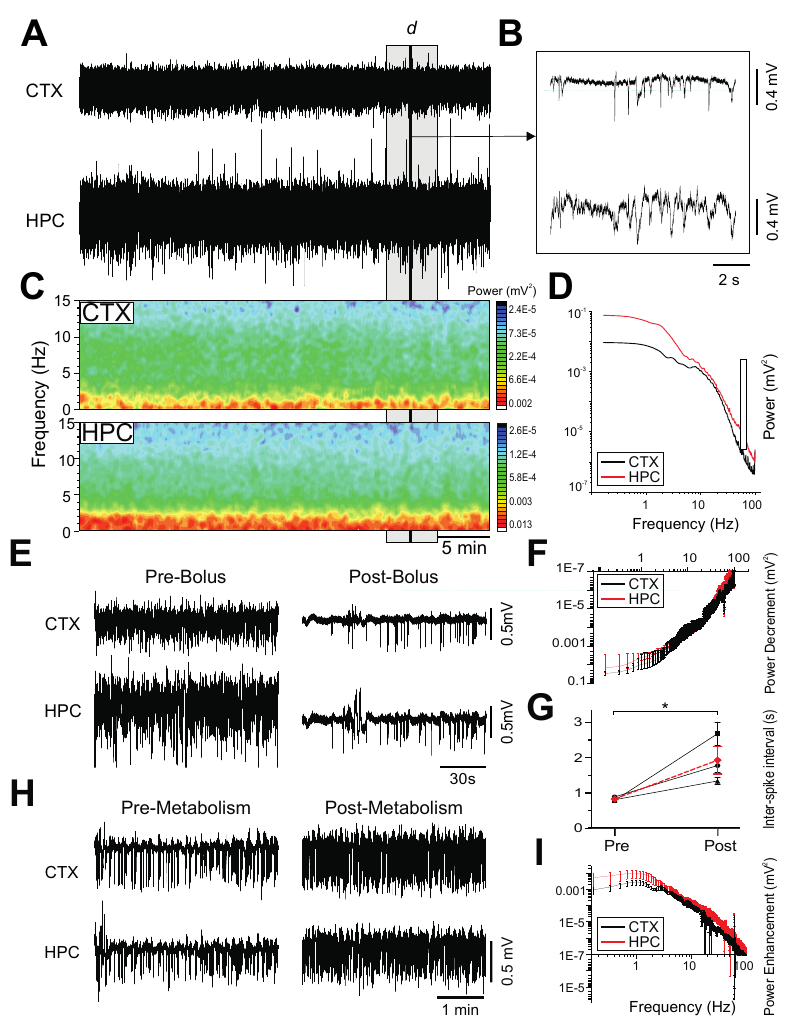
Figure 5. Burst-suppression activity under propofol anesthesia. ( A ): Continuous, 40 min duration cortical (CTX) and hippocampal (HPC) EEG traces. A 5 min (grey box) sample is further analyzed in D, and a 10 s (black line) sample is expanded in B. ( B ): Expanded 10 s trace of CTX and HPC from A (black line). ( C ): Spectrograms of CTX and HPC traces in A. ( D ): Power spectra of a 5 min selection from A (grey box), representative of the activity observed throughout the 40 min duration of the trace in A, due to continuous delivery of propofol. Noise at 60 Hz has been obfuscated by a white box. ( E ): Pre-bolus: A 2 min sample of CTX and HPC traces during a surgical plane of propofol anesthesia. Post-bolus: A 2 min sample of activity following a bolus infusion of propofol (2 mg). ( F ): The average difference in spectral power following a bolus (2 mg) of propofol, plotted using